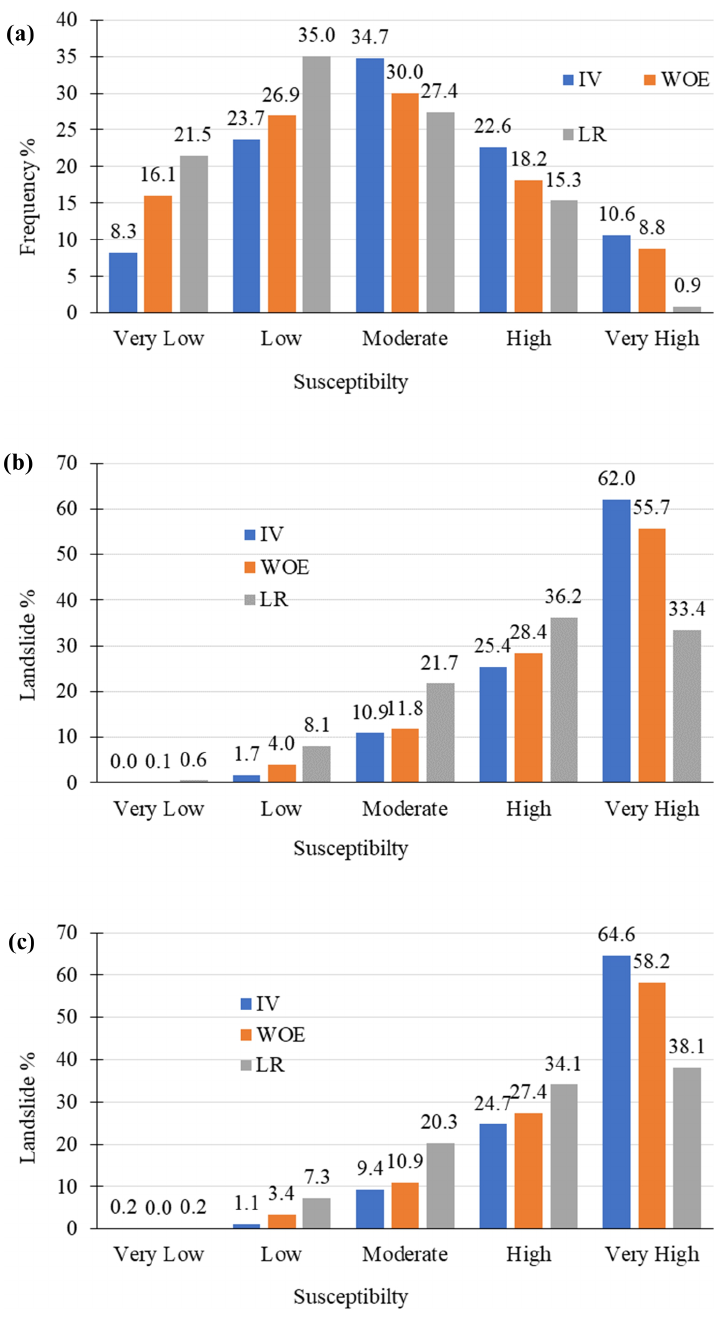
Figure 9. Density of landslides in each susceptibility class for the IV, WOE, and LR models using the ( a ) training sample, ( b ) training landslide sample, and ( c ) control landslide